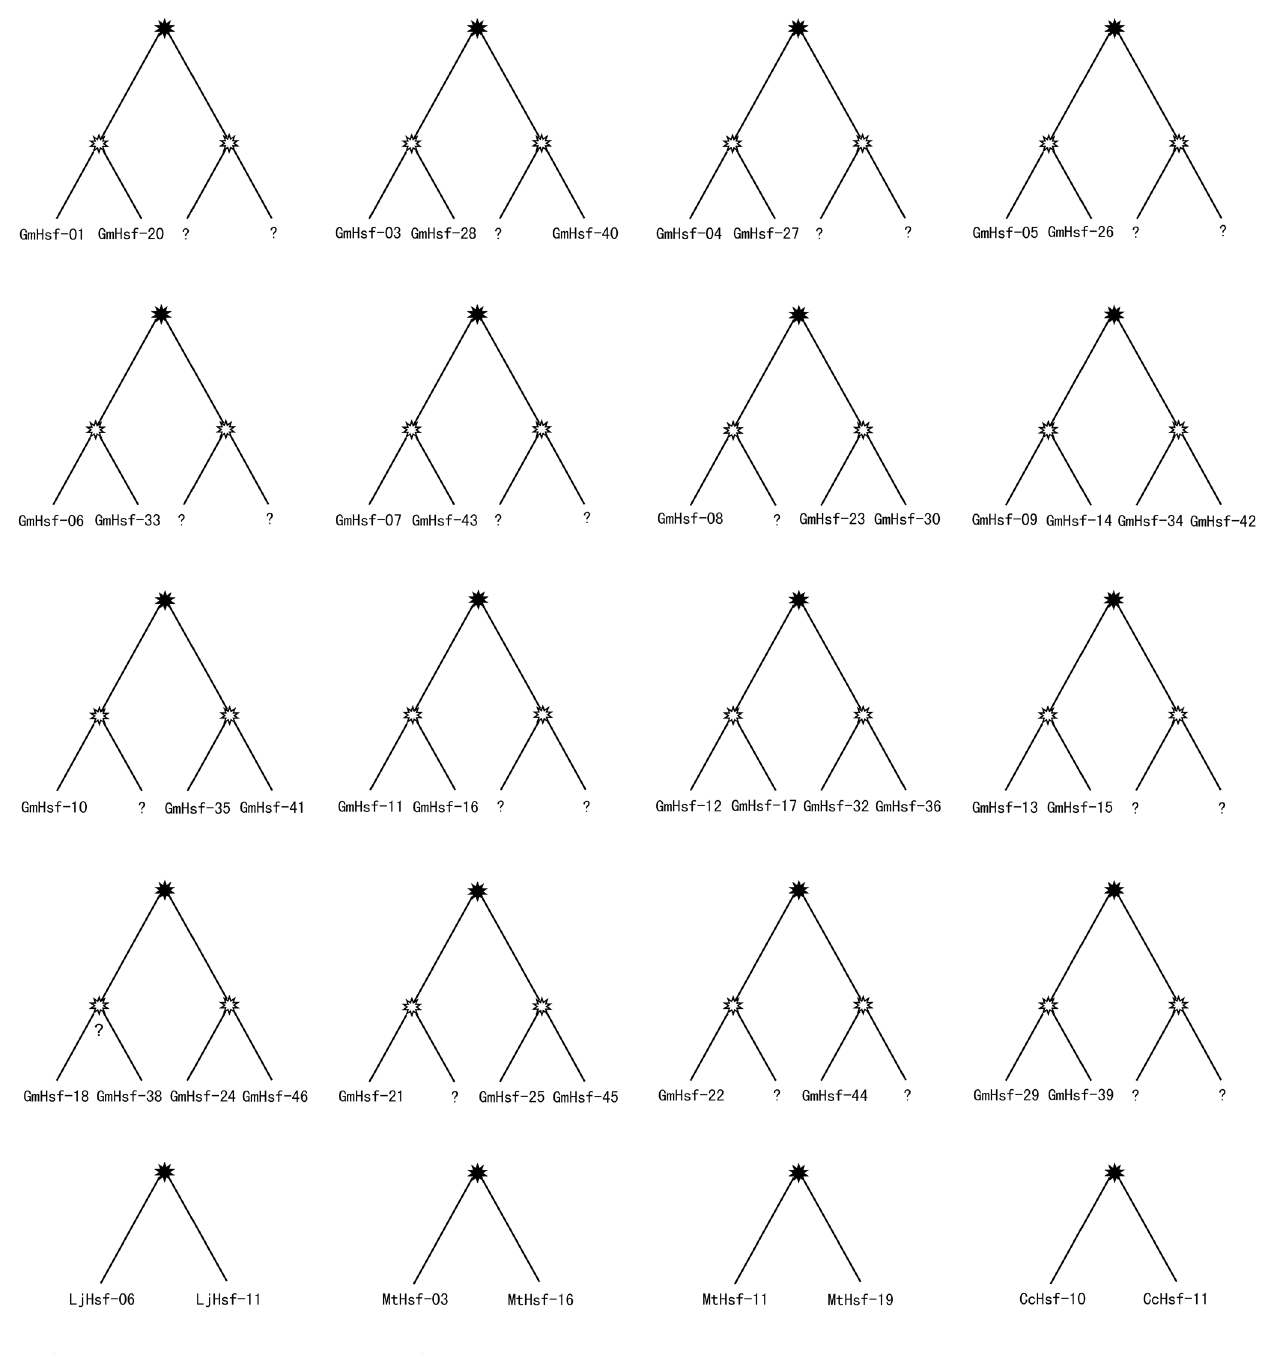
Figure 2. Idealized gene trees of the duplication groups of Hsf genes in G.max , L . japonicus , M . truncatula and C . cajan . Each tree represents a duplication group from large-scale gene duplication. As shown in the trees, every Hsf gene of G. max was expected to be present in four copies after two rounds of whole-genome duplication (early and recent). Similarly, the number of Hsf genes in L . japonicus , M . truncatula and C . cajan will have doubled after the early-legume whole-genome duplication. The five duplicated gene pairs ( LjHsf-06 / LjHsf-11 , GmHsf-09 / GmHsf-34 , GmHsf-18 / GmHsf-24 , GmHsf-18 / GmHsf-46 and GmHsf-21 / GmHsf-45 ) were classified in the flexible set. The question marks indicate possible gene loss events. The GmHsf-18/GmHsf-38 pair could be formed by a segmental duplication that predated the recent whole-genome duplication, and both the GmHsf-18 and GmHsf-38 lost homoeologs from the recent whole-genome duplication. doi:10.1371/journal.pone.0102825.g002 any chromosome. In M. truncatula , genes flanking both pairs, MtHsf-08 / MtHsf-09 ) were located near each other on chromo- somes 2 and 4, and thus most likely resulted from tandem MtHsf-03 / MtHsf-16 and MtHsf-11 / MtHsf-19 , were found to be conserved. In addition, two gene pairs ( MtHsf-04 / MtHsf-05 and duplication. Moreover, we found that the DNA sequences for